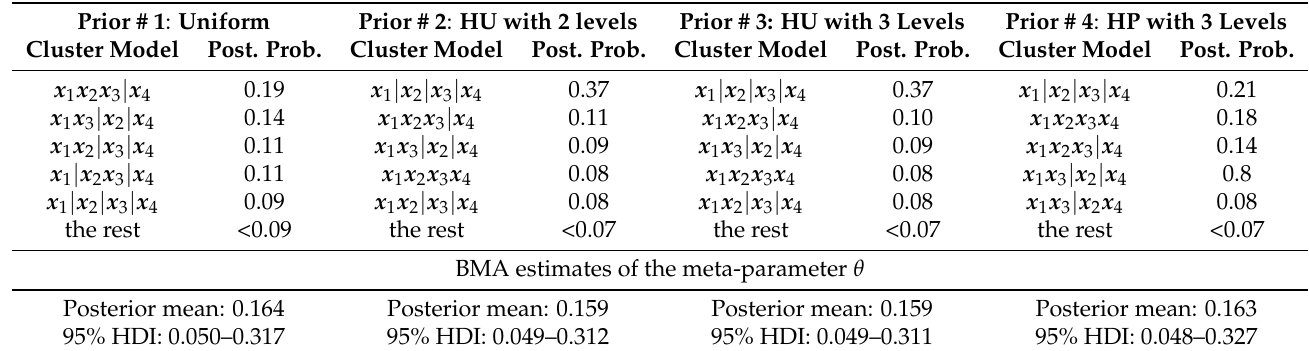
Table 3. Top cluster models in Stanworth et al. for treatment